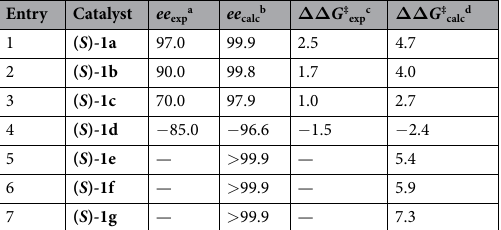
Table 1. Theoretically predicated and experimentally observed enantioselectivities with a series of binaphthophosphepine catalysts. a The ee value obtained in experiment. b The ee value obtained in theoretical calculation. c ΔΔ G ‡ exp is extrapolated by experimentally observed ee ( ΔΔ G ‡ = − RTln(1 − ee )/ (1 + ee )). d ΔΔ G ‡